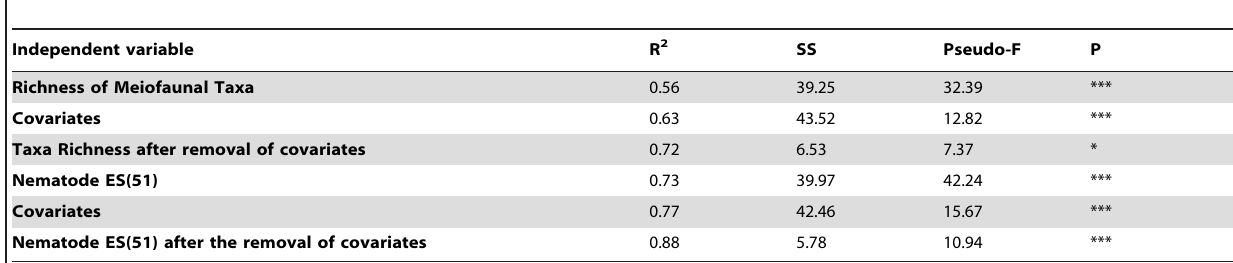
Table 6. Effects of biodiversity, measured as richness of meiofaunal taxa and nematode expected species number ES(51), on ecosystem functioning, as prokaryotic heterotrophic production before and after the removal of the covariables’ effect: longitude, sediment biopolymeric organic C content and the protein to carbohydrate